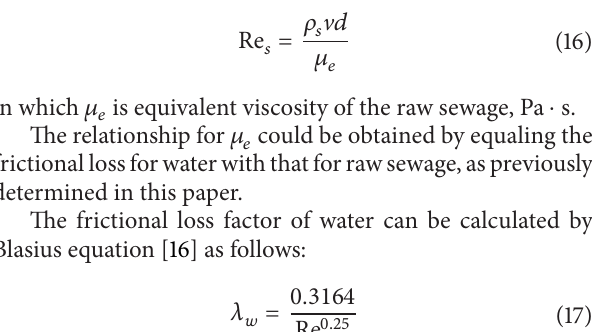
is regarded as 1000 kg/m 3 , the same as the water density. With the same diameter and flow rate, the ratio of the equivalent viscosity 𝜇 𝑒 to the water viscosity can be found